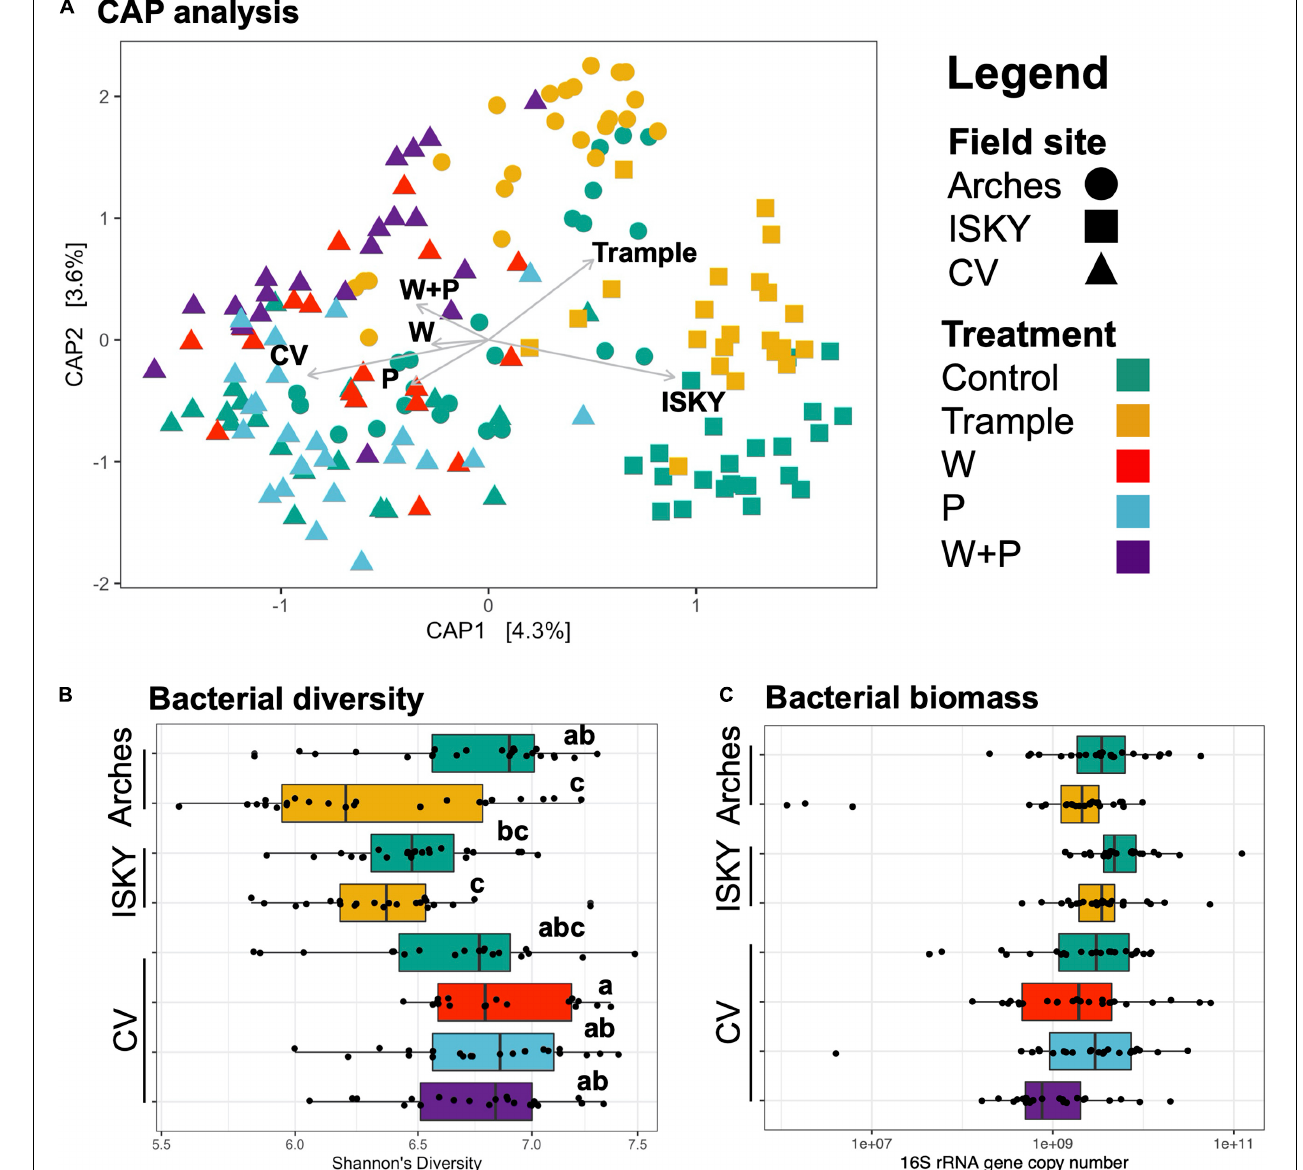
FIGURE 2 | Bacterial composition, diversity, and biomass across the datasets. (A) Canonical analysis of principal coordinates ordination of sequence datasets. Axes labels denote the percent variation explained by principal components. Arrows indicate the direction and magnitude of the variance explained by field site and manipulation treatments. (B) Bacterial diversity. Diversity was assessed by the non-parametric Shannon’s diversity index. Boxplots show the mean (solid bar) and interquartile range of the values. Each individual sample is represented by the black points. Samples labeled with different letters were significantly different by ANOVA testing of means followed by a post hoc Tukey-Kramer test. (C) Bacterial abundance as determined by qPCR of bacterial 16S rRNA genes. Boxplots show the mean (solid bar) and interquartile range of the values. Each individual sample is represented by the black points. No significant differences between datasets were